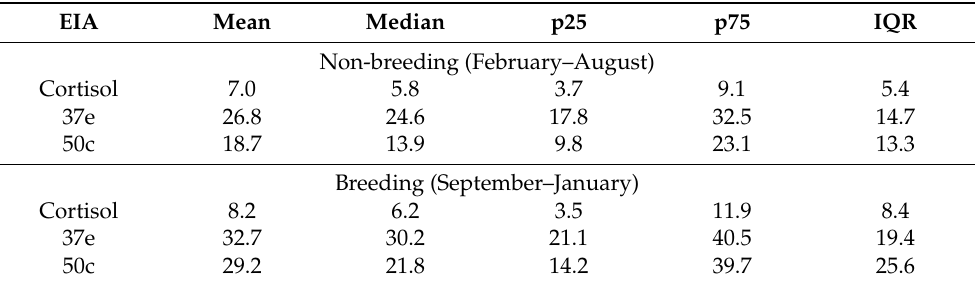
Figure 7. Box and whisker plots for FCM (faecal cortisol metabolite) values (ng/g) measured with the cortisol, 37e (5 α - pregnane-3 β ,11 β ,21-triol-20-one) and 50c (tetrahydrocorticosterone) EIAs (enzyme immunoassays) (1: non-breeding season (February–August); 2: breeding season (September–January); defecations: n = 199 and n = 152 respectively). Table 4. Summary statistics for FCM (faecal cortisol metabolites) values measured with the cortisol, 37e and 50c EIAs (enzyme immunoassays) by breeding season.